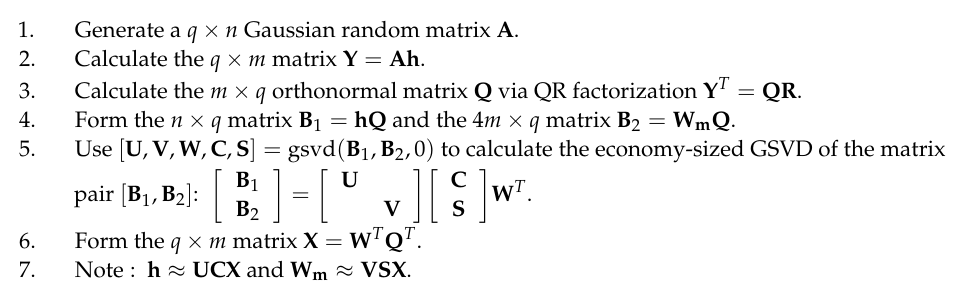
Algorithm 2. Randomized generalized singular value decomposition (RGSVD)